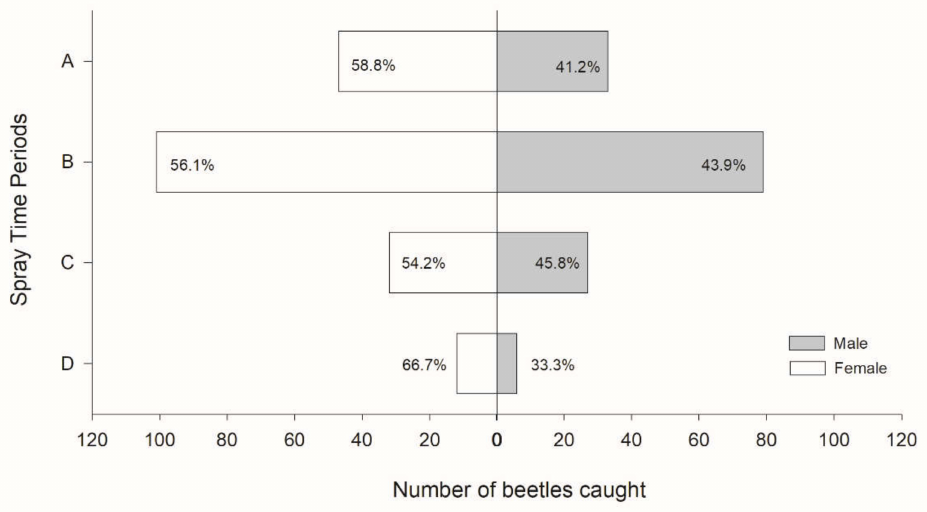
Figure 4. Mean numbers of beetles by sex in each spray time period. The number represents the proportion at each spray time period. Spray time period A: 05:00–11:00, B: 11:00–17:00, C: 17:00–23:00, and D: 23:00–05:00. No significant differences were observed between